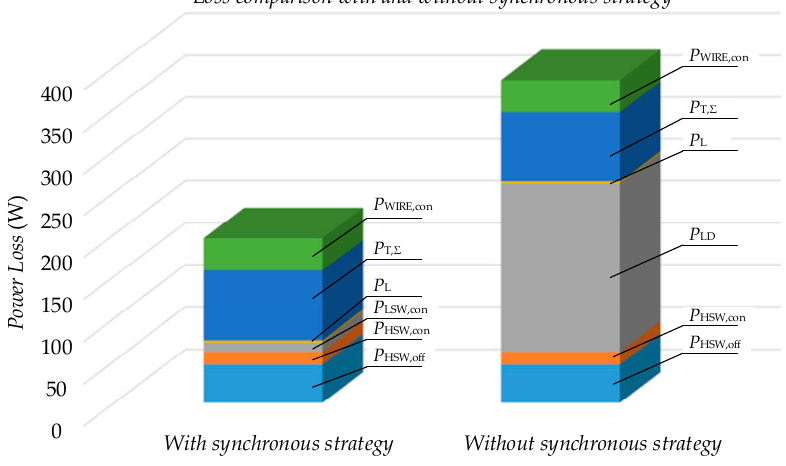
Figure 13. The power loss distribution and comparison with and without synchronous strategy.